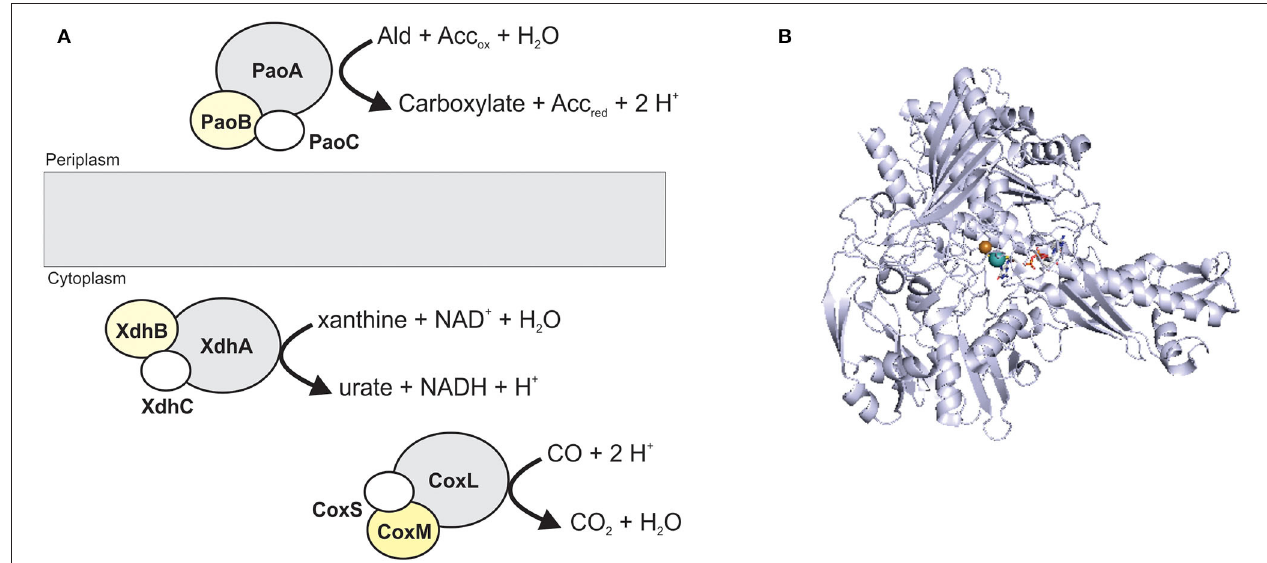
FIGURE 3 | The structure and location of typical XO family enzymes. (A) schematic representation of enzyme structure. Enzymes of this family most commonly have a heterotrimeric ( αβγ ) structure containing a Mo-binding catalytic subunit (gray); an iron-sulfur protein (white); a FAD-binding subunit (yellow). CoxMSL is a carbon monoxide dehydrogenase, XdhABC is a xanthine dehydrogenase and PaoABC is an aldehyde oxidoreductase. (B) Crystal structure of CoxL, the catalytic subunit of the carbon monoxide dehydrogenase from Oligotropha carboxidovorans (PDB: 1N63) with the CuMo-PCD cofactor shown in stick form. Colors: white – carbon, blue – nitrogen, orange – phosphor, red – oxygen, yellow – sulfur, light teal– molybdenum, brown– copper, protein backbone - bluewhite.